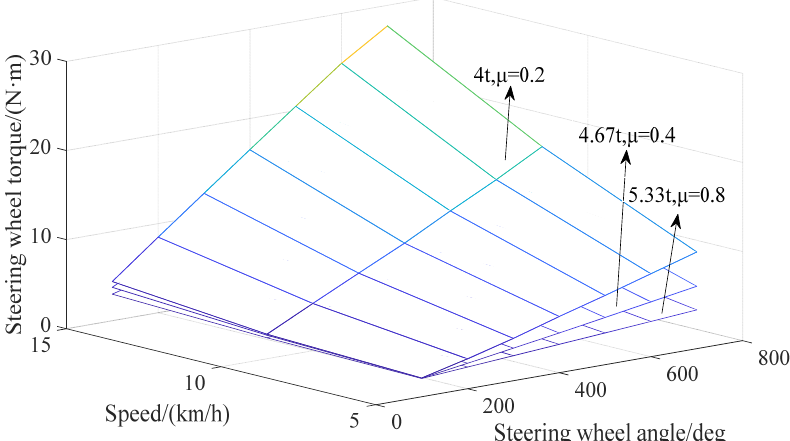
Figure 7. The relationship curve between steering wheel torque and vehicle speed and steering wheel at low speed.